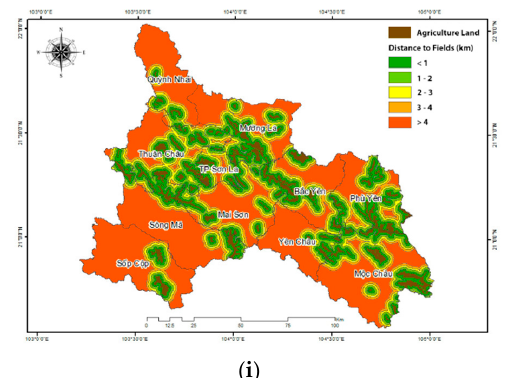
Figure 5. Information layers for the establishment of a forest fire risk map in Son La Province: ( a ) slope; ( b ) elevation; ( c ) slope direction; ( d ) forest cover; ( e ) distance to roads; ( f ) distance to residential areas; ( g ) humidity; ( h ) distance to rivers; and ( i ) distance to fields.